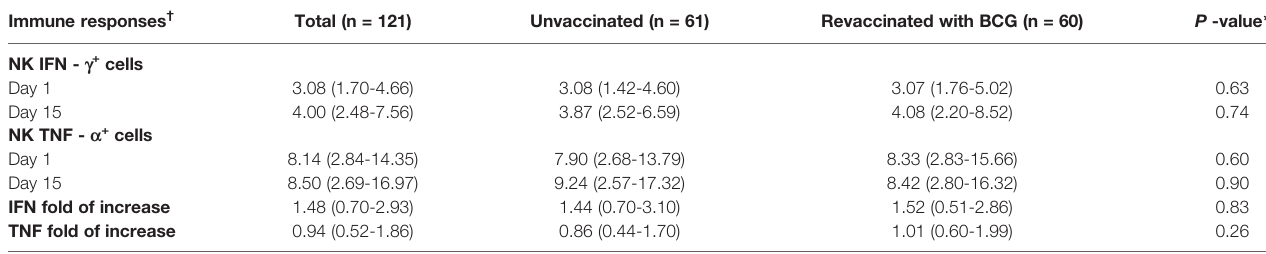
TABLE 7 | NK responses to M. bovis -CFP stimulation in BCG and unvaccinated groups. Immune responses †